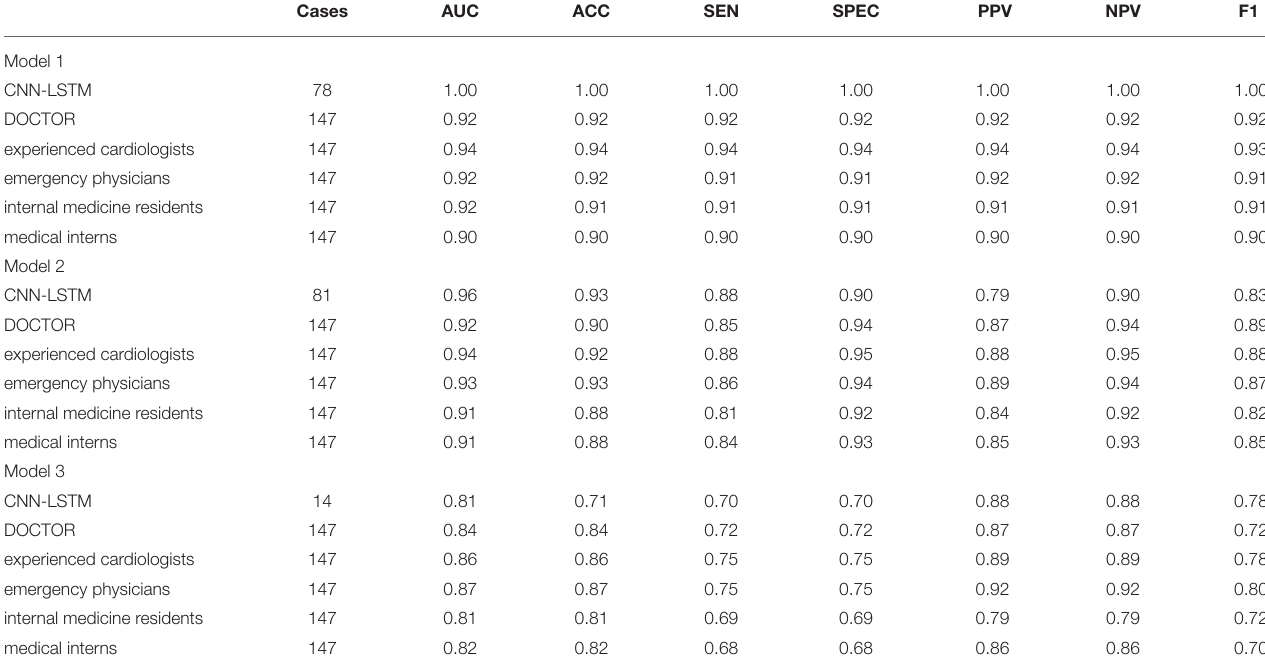
TABLE 4 | Diagnosis performance of CNN-LSTM and of different levels of doctors. Cases AUC